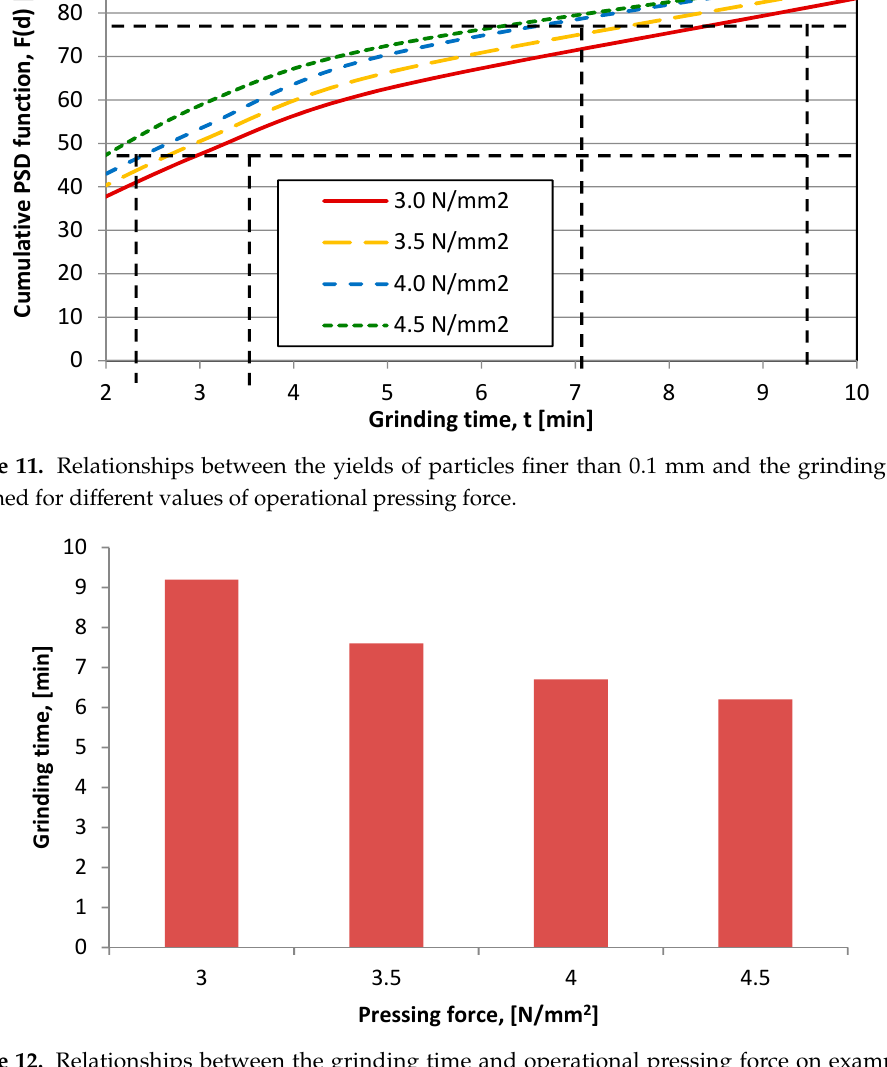
Figure 11. Relationships between the yields of particles finer than 0.1 mm and the grinding time, obtained for different values of operational pressing force.